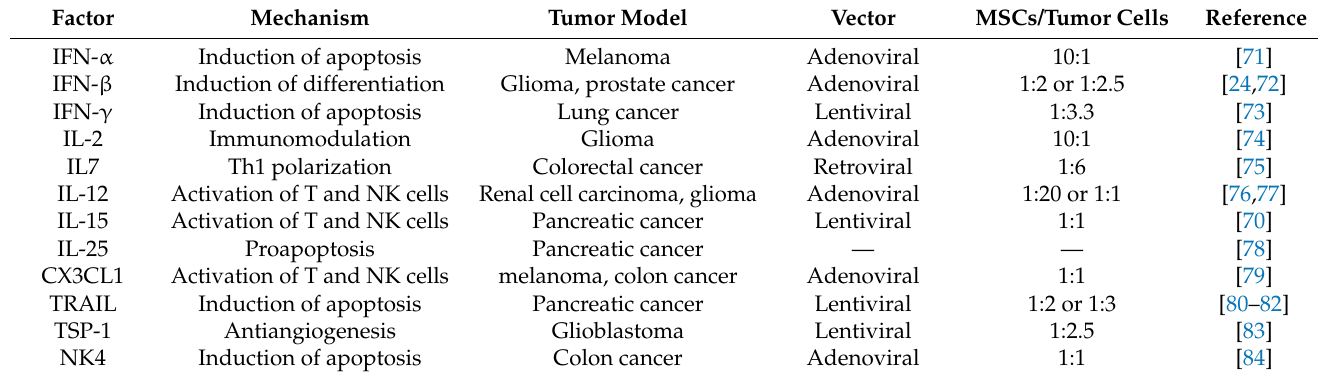
Table 2. Bioactive molecule therapy for cancers using